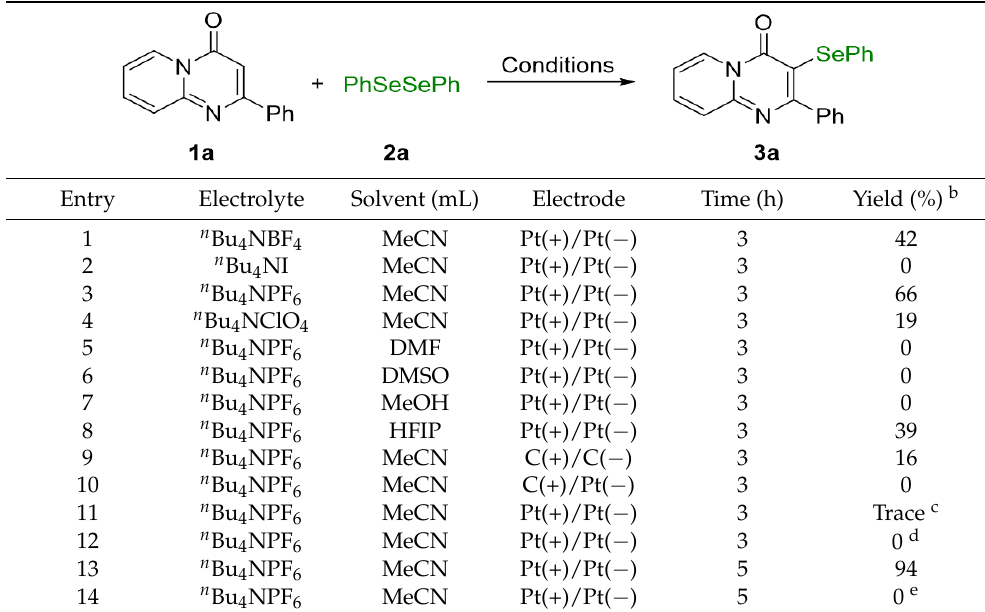
Table 1. Optimization of reaction conditions a .